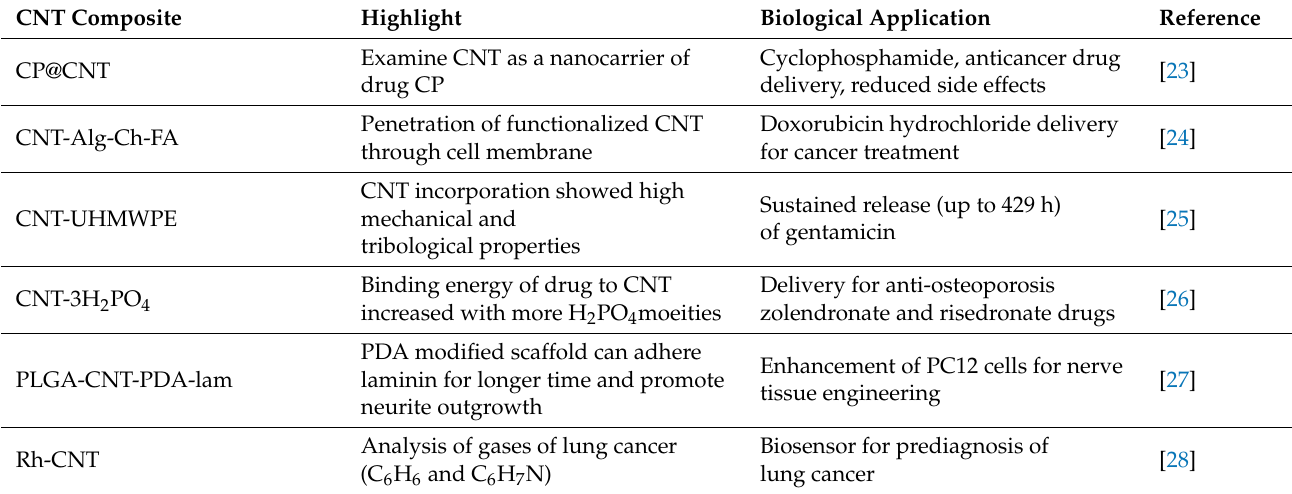
Table 1. List of CNTs-based composites and their biological